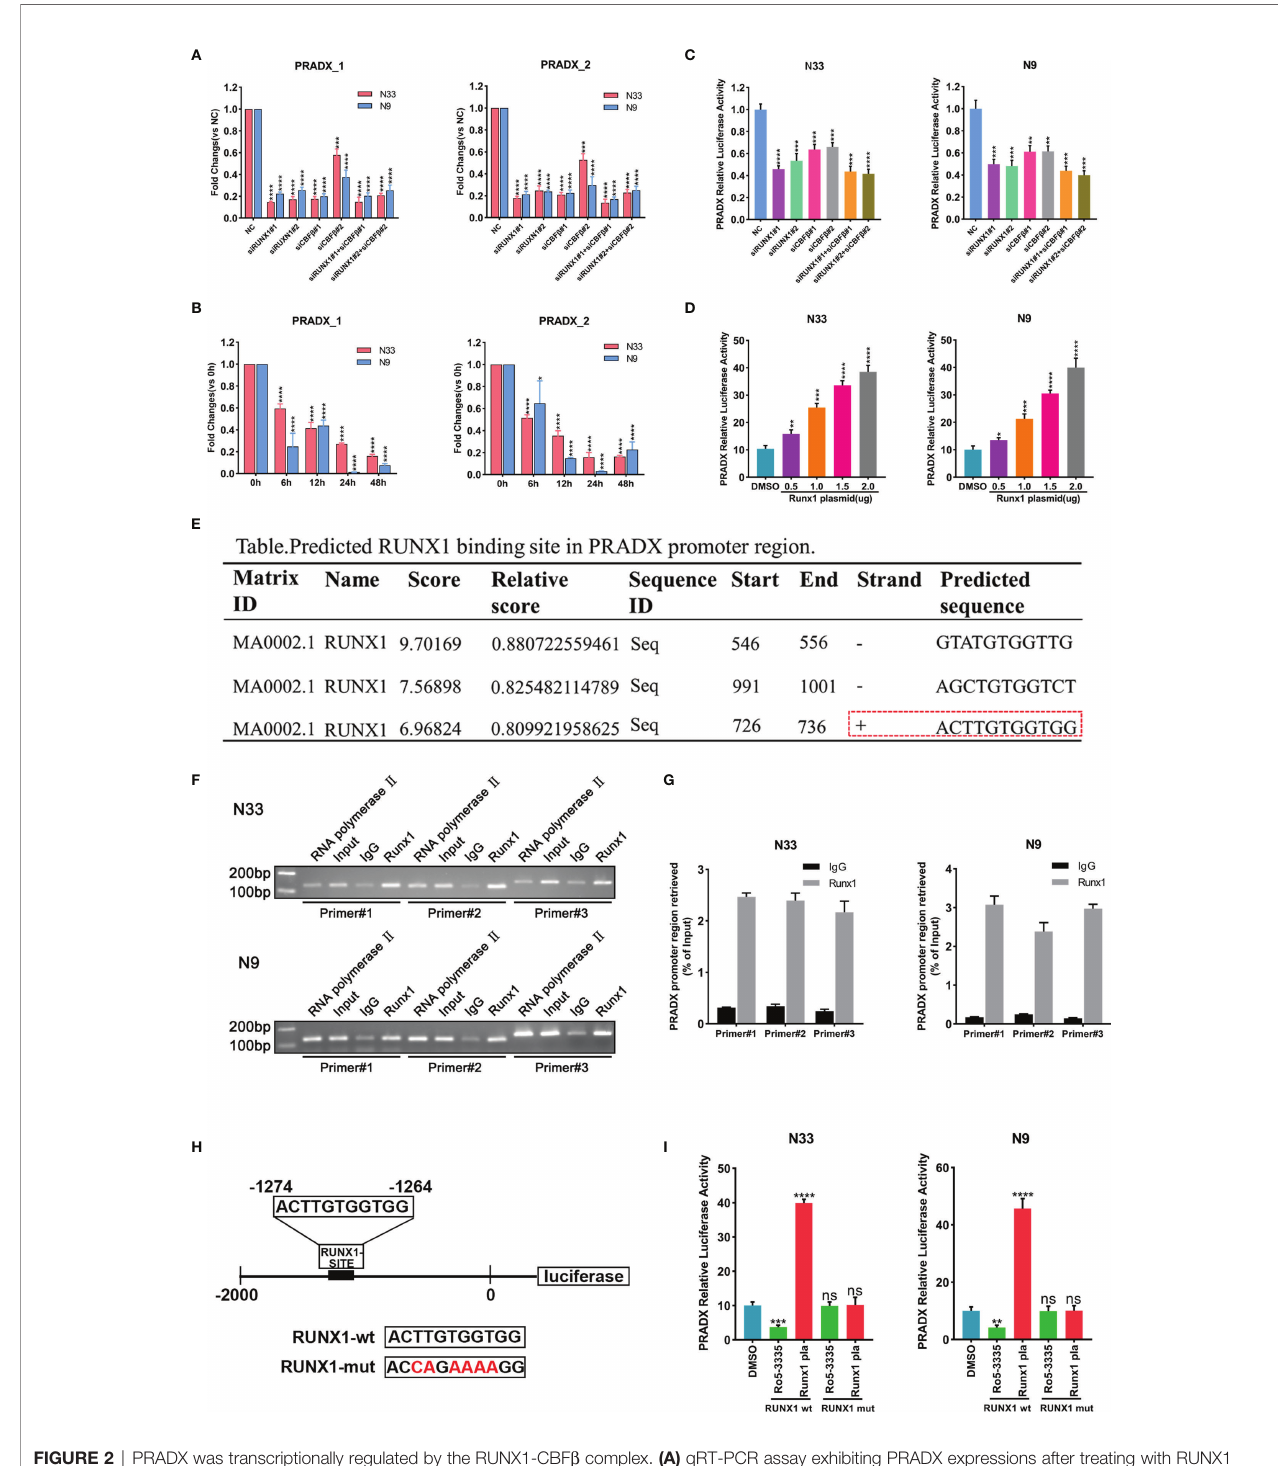
FIGURE 2 | PRADX was transcriptionally regulated by the RUNX1-CBF b complex. (A) qRT-PCR assay exhibiting PRADX expressions after treating with RUNX1 and/or CBF b siRNA. (B) qRT-PCR showing PRADX expressions after treating with RO5-3335 for different times. (C, D) Dual-luciferase report assay showing the transcriptional activity of PRADX after treating with RUNX1, CBF b siRNA, or RUNX1 expression plasmid. (E) The binding site of RUNX1 in the PRADX promoter region as predicted by the JASPAR tool. (F, G) ChIP-PCR and ChIP-qPCR analyses show RUNX1 binds to the predicted binding site on the PRADX promoter. (H, I) RUNX1 binding site mutated plasmid construction for dual-luciferase reporter assay to compare PRADX transcription activities following RO5-3335 treatment or RUNX1 expression plasmid transfection in the indicated groups. Data are represented as mean ± standard deviation (SD); n = 3 independent experiments. ****P <0.00001, ***P <0.0001, **P <0.001, *P <0.05. ns: no signi fi